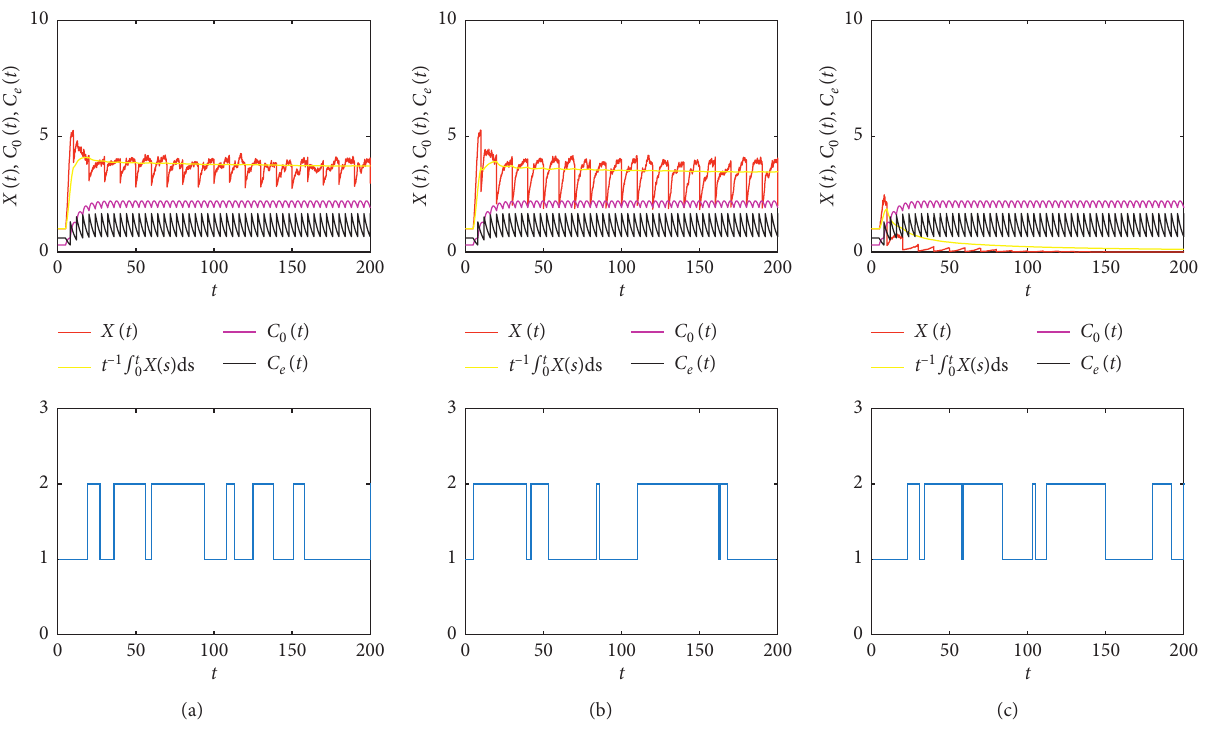
Figure 6: Effect of impulse: (a) δ